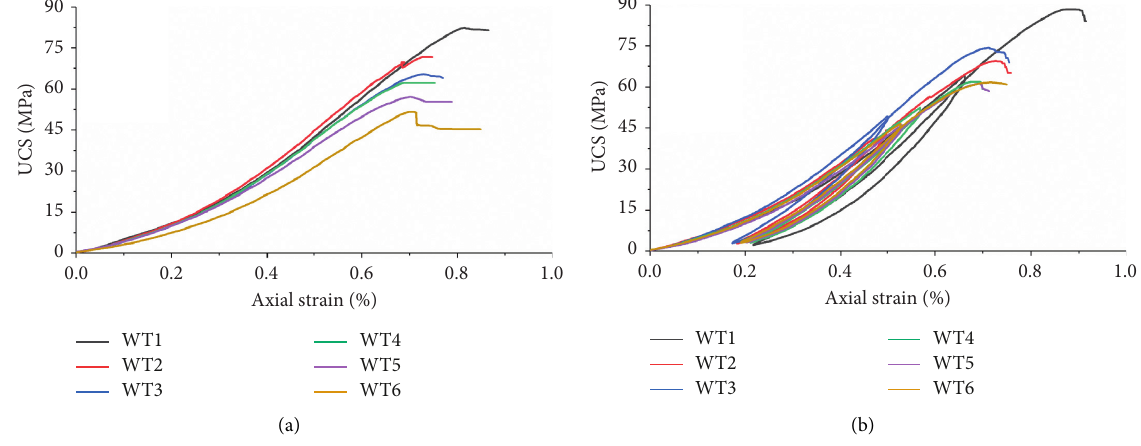
Figure 6: Axial stress-axial strain curves (a) and loading and unloading curves (b) of sandstone.